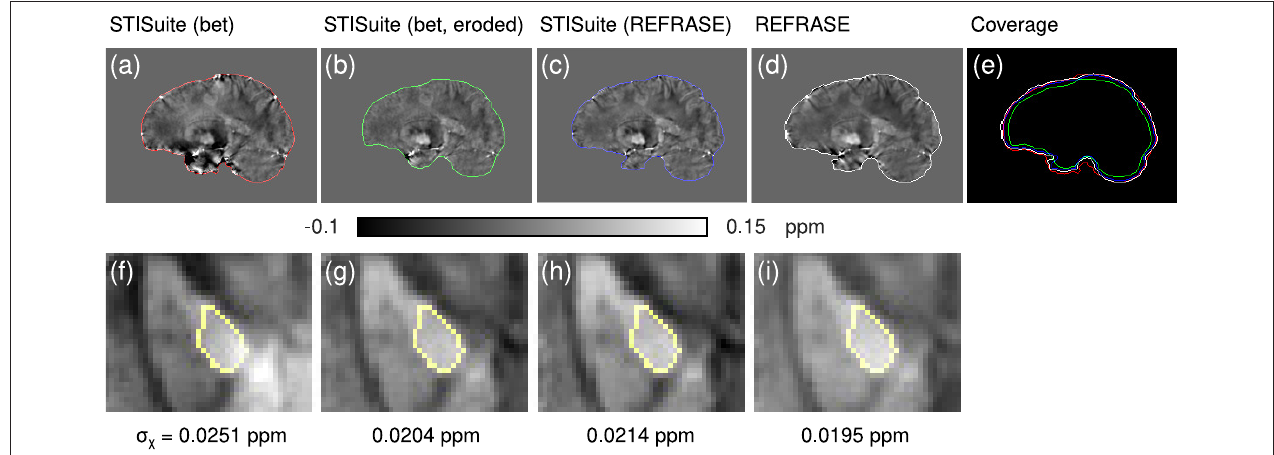
FIGURE 12 | Comparison of different QSM reconstruction configurations: (a,f) STI Suite with FSL-bet2 mask, V-SHARP, and StarQSM; (b,g) STI Suite with eroded FSL-bet2 mask, V-SHARP, and StarQSM; (c,h) STI Suite with REFRASE phase and mask ( Q LC,min = 0.7, five iterations), V-SHARP and StarQSM; (d,i) REFRASE (same configuration) with MUBAFIRE and in-house QSM reco. Image (e) illustrates the masks of all methods. Row one (a–e) shows a sagittal sample slice from volunteer one, while row two (f,g) illustrates a magnified, transverse view of a sample slice indicating the analysed control region within the pallidum. Below each image, the standard deviation within the entire control region is printed, indicating the